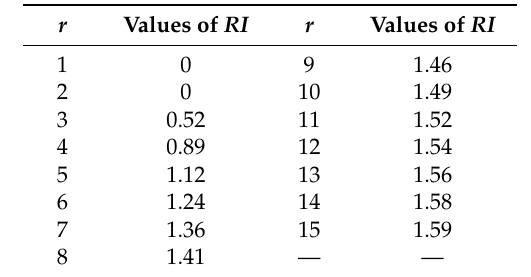
Ratio of the importance of indicator j to indicator i Table 3. The assignment table for RI